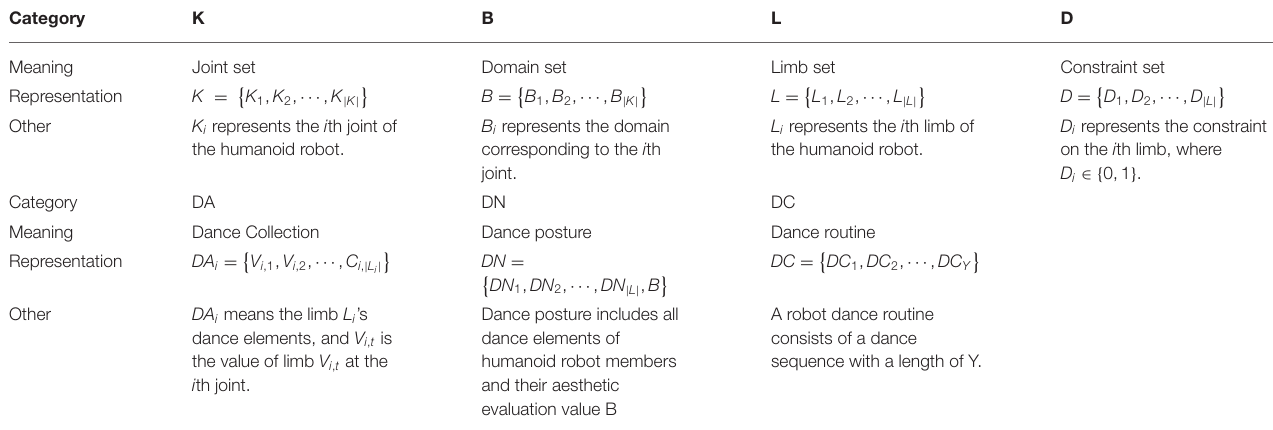
TABLE 1 | Humanoid robot dance representation space: